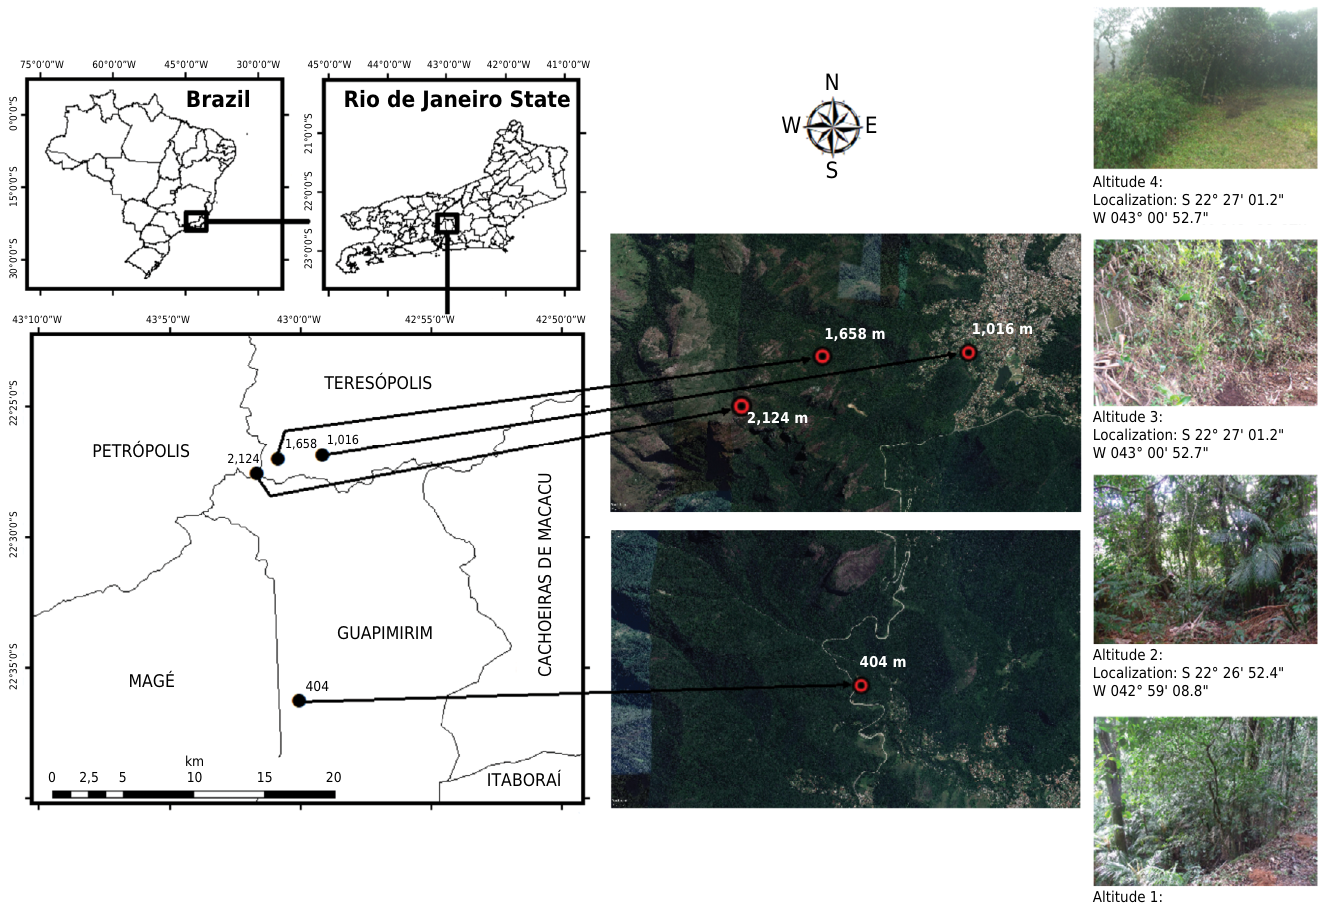
Figure 1. Geographical location of the PARNASO in the state of Rio de Janeiro, Brazil; and the four collecting points and their respective altitudes ranging from 404 to 2,124